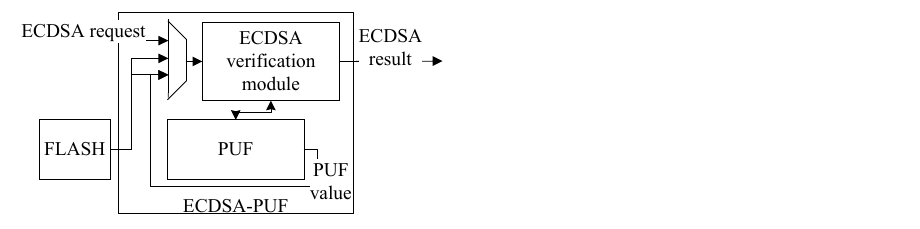
Figure 15. Fast ECDSA-PUF and custom ECDSA shares the same ECDSA verification module.